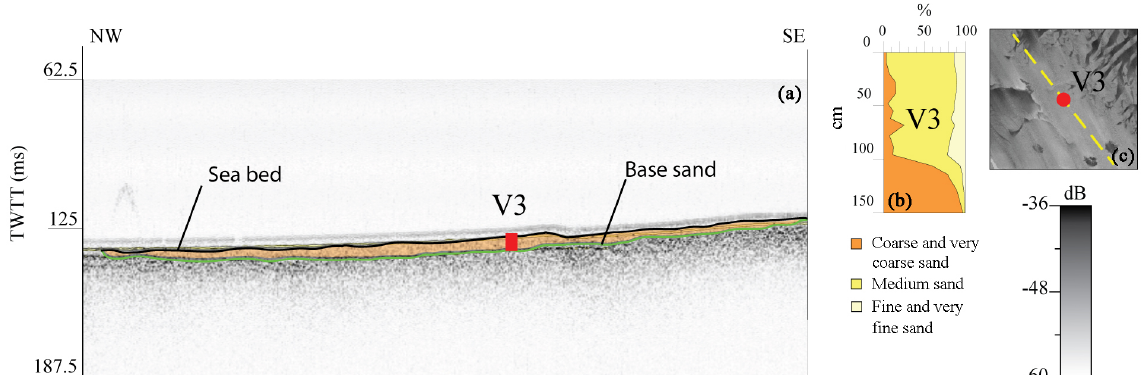
Figure 4. (a) Example of digitisation of the sand base in a chirp profile which is correlated with the core V3; (b) stratigraphic profile of the cores located on the chirp profile; (c) relative backscatter intensity